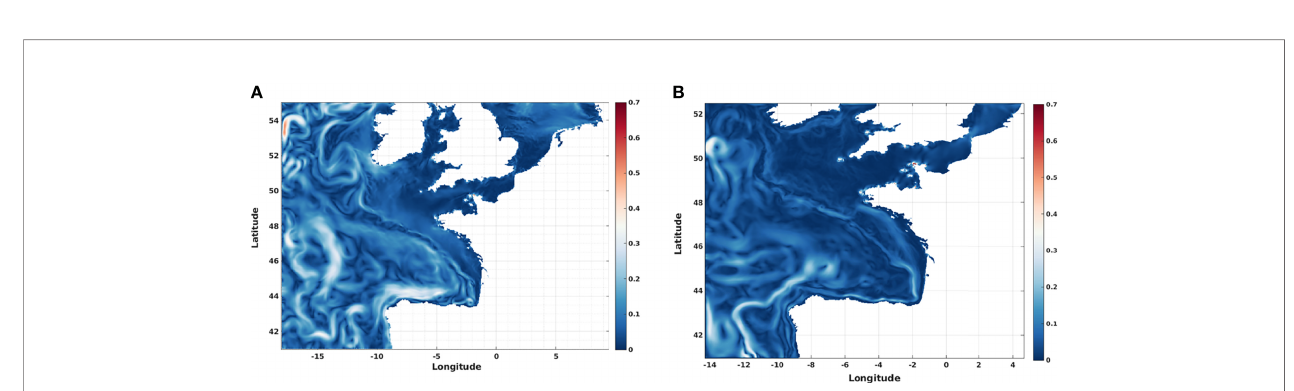
FIGURE 4 | Sample surface fl ow fi elds of the hydrodynamical models in November 2010. (A) The 4 km horizontal resolution model and (B) The 1 km horizontal resolution